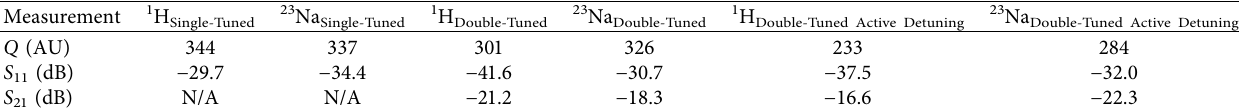
Figure 5: (a) Photograph of the double-tuned birdcage in the shield. (b) Photograph of the saddle coil insert into the double-tuned birdcage former. (c) Photograph of the saddle and birdcage side by side showing the dimensions and positioning of the saddle within the birdcage. Yellow Kapton ® tape is also visible, electrically isolating the hydrogen birdcage end rings from the sodium birdcage legs. Table 2: Double-tuned birdcage bench